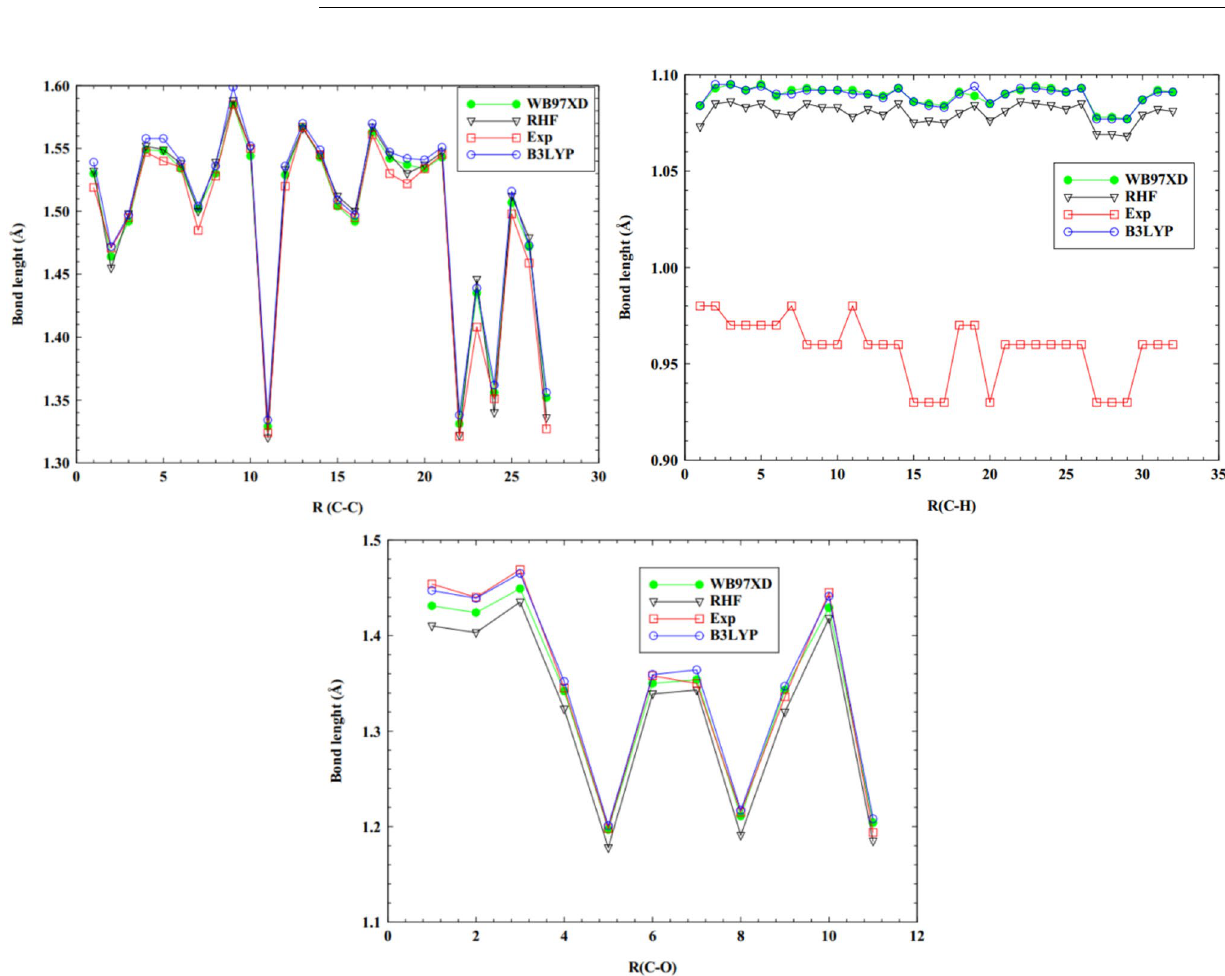
Fig. 3 Variation of the bond lengths calculated by B3LYP, wB97XD and RHF. The experimental data [4] are also illustrated for